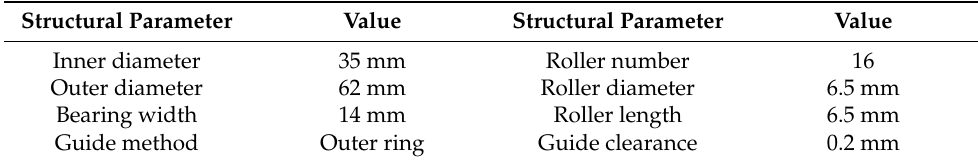
Guide method Outer